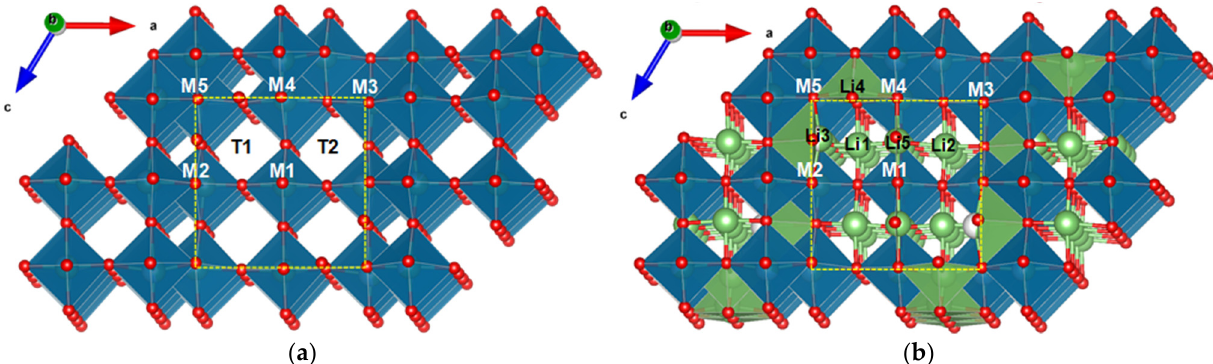
Figure 1. The crystal structure of ( a ) TNO and ( b ) Li 4 TiNb 2 O 7 with Li and Nb/Ti positions. Yellow dashed frames mark (3 × 3) ∞ of ReO 3 -like blocks. dashed frames mark (3 × 3) ∞ of ReO 3 -like